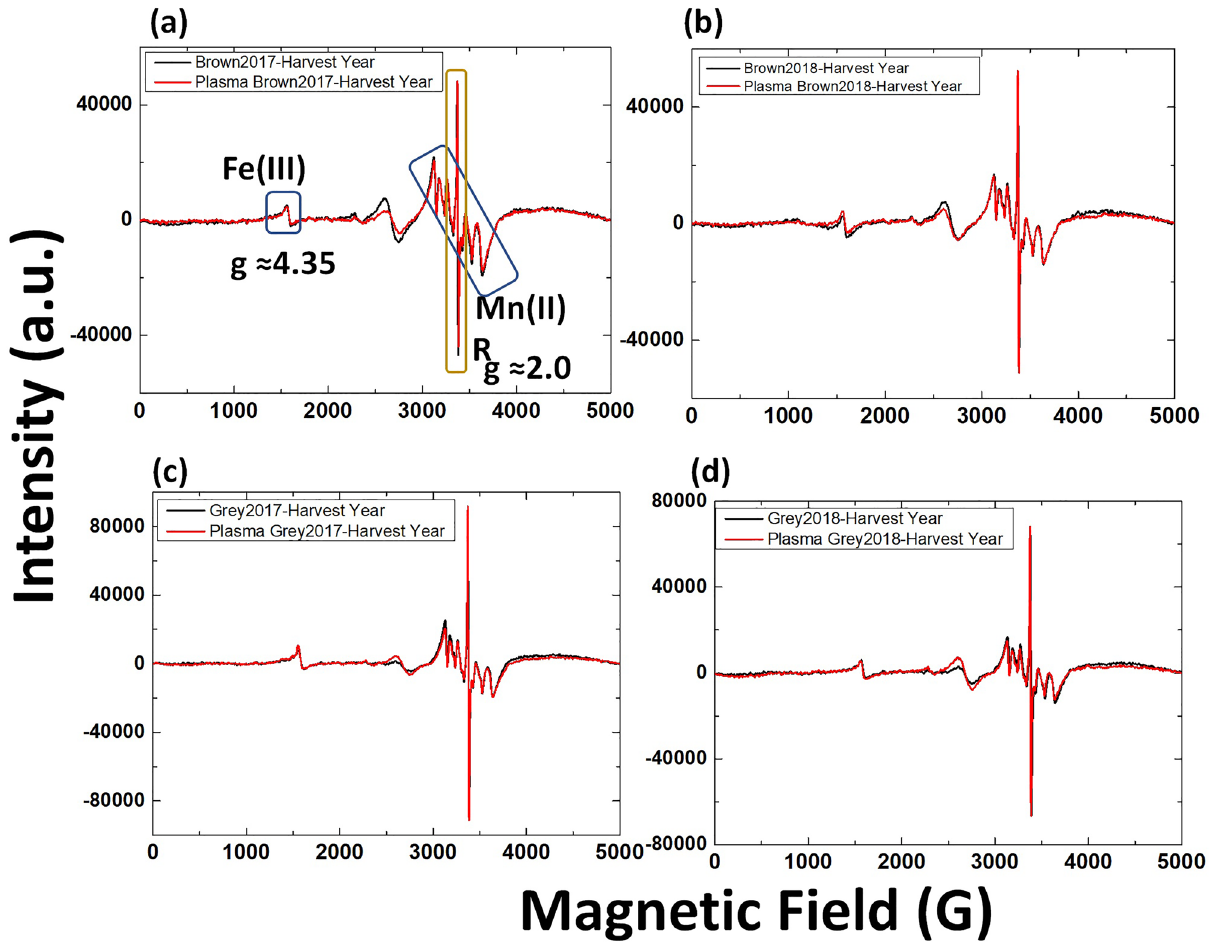
Figure 4. EPR spectra of radish seeds harvested in 2017 or 2018 before (black line) and after plasma treatment (red line) (a) brown seeds harvested in 2017, (b) brown seeds harvested in 2018, (c) 2017-harvest year grey seeds and (d) 2018-harvest year grey seeds. Ten seeds were used in one